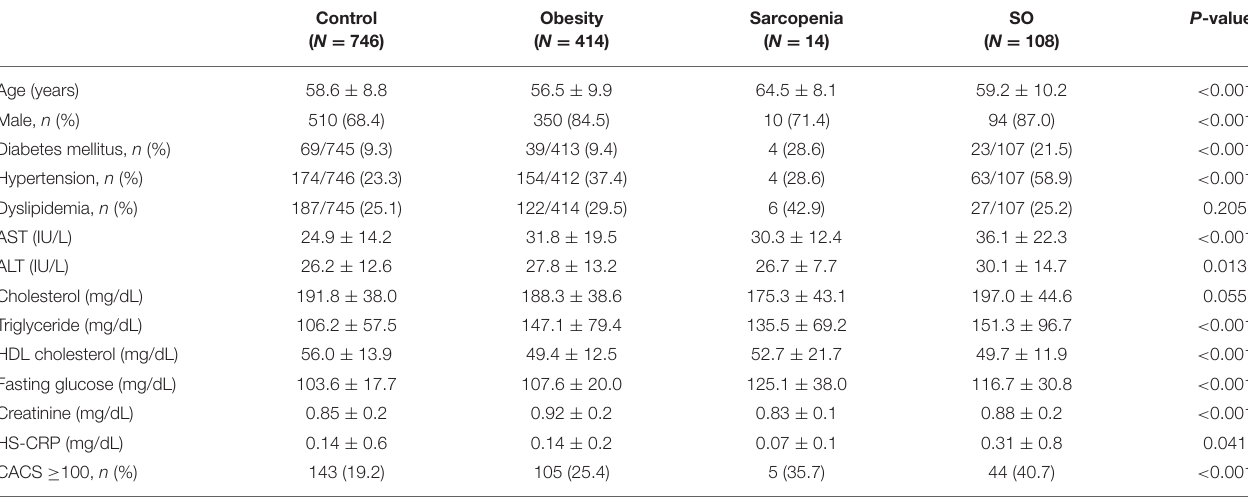
TABLE 2 | Comparison of baseline characteristics according to sarcopenia with/without obesity.